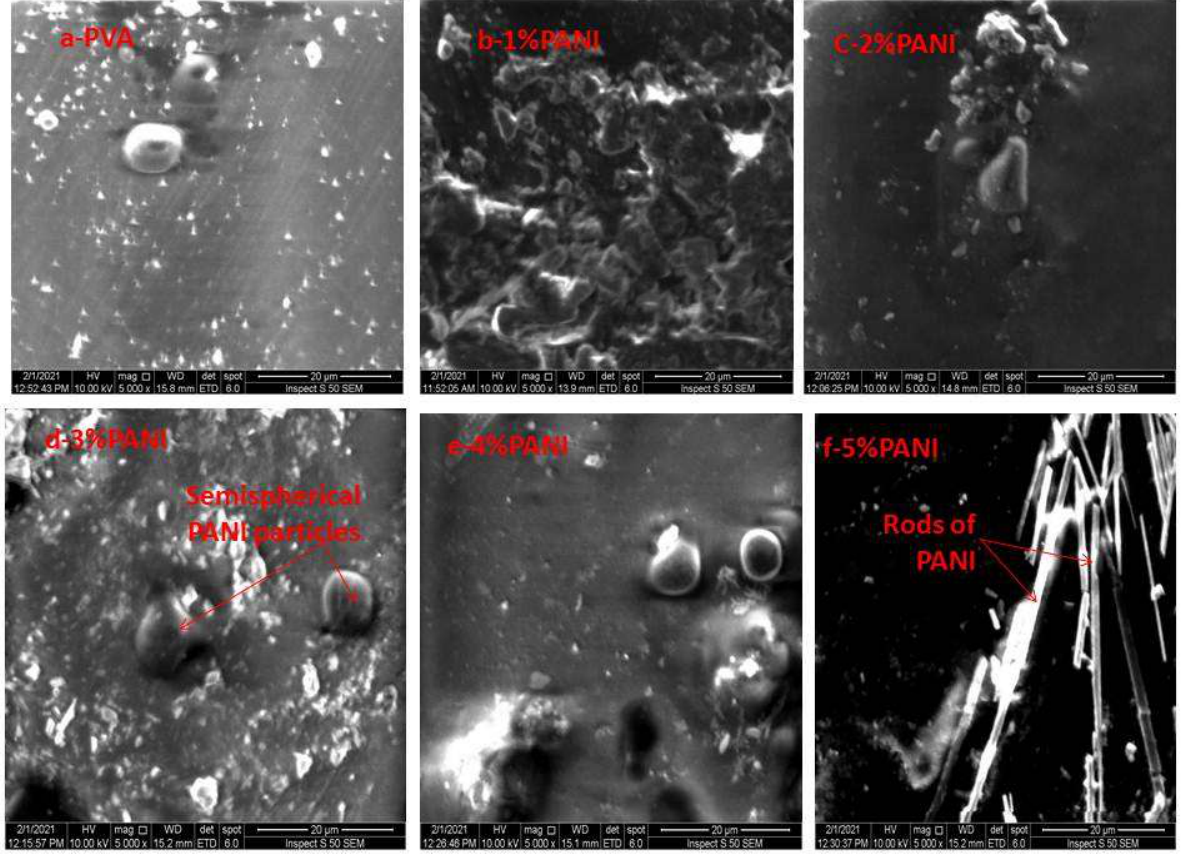
Figure 1: SEM images of PVA before and after PANI additions at different weight ratios